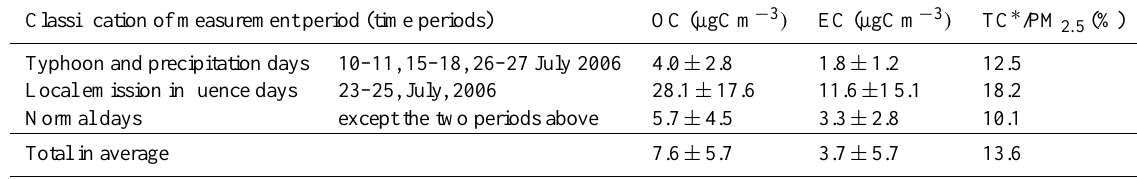
Table 1. Comparisons of carbonaceous aerosol concentrations in three typical periods in the PRIDE-PRD 2006 campaign. Classification of measurement period (time periods)